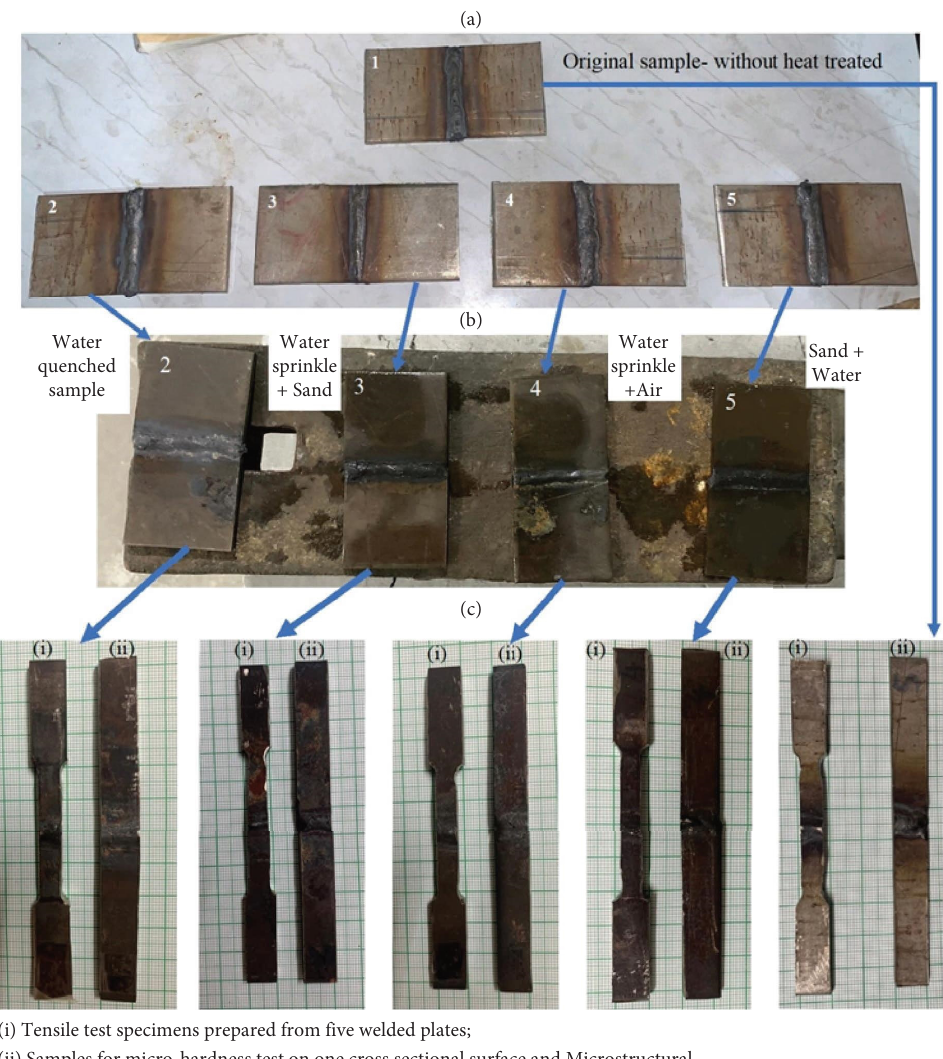
Figure 2: Details of experimental work: (a) fve welded plates indicated by 1, 2, 3, 4, and 5; (b) four heat-treated plates; (c) (i) the tensile test specimens; (ii) specimens for hardness and the microscopic test.